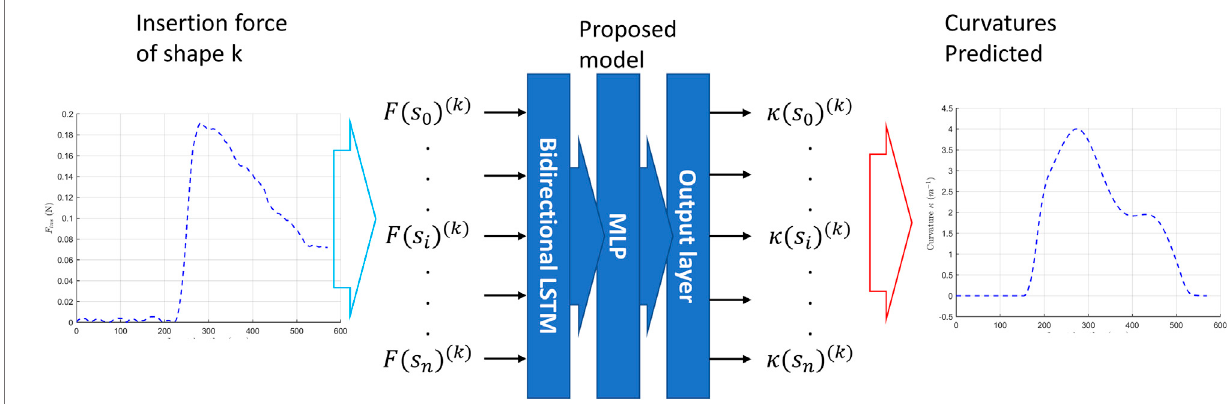
FIGURE 7 | An illustration of the proposed neural network model.